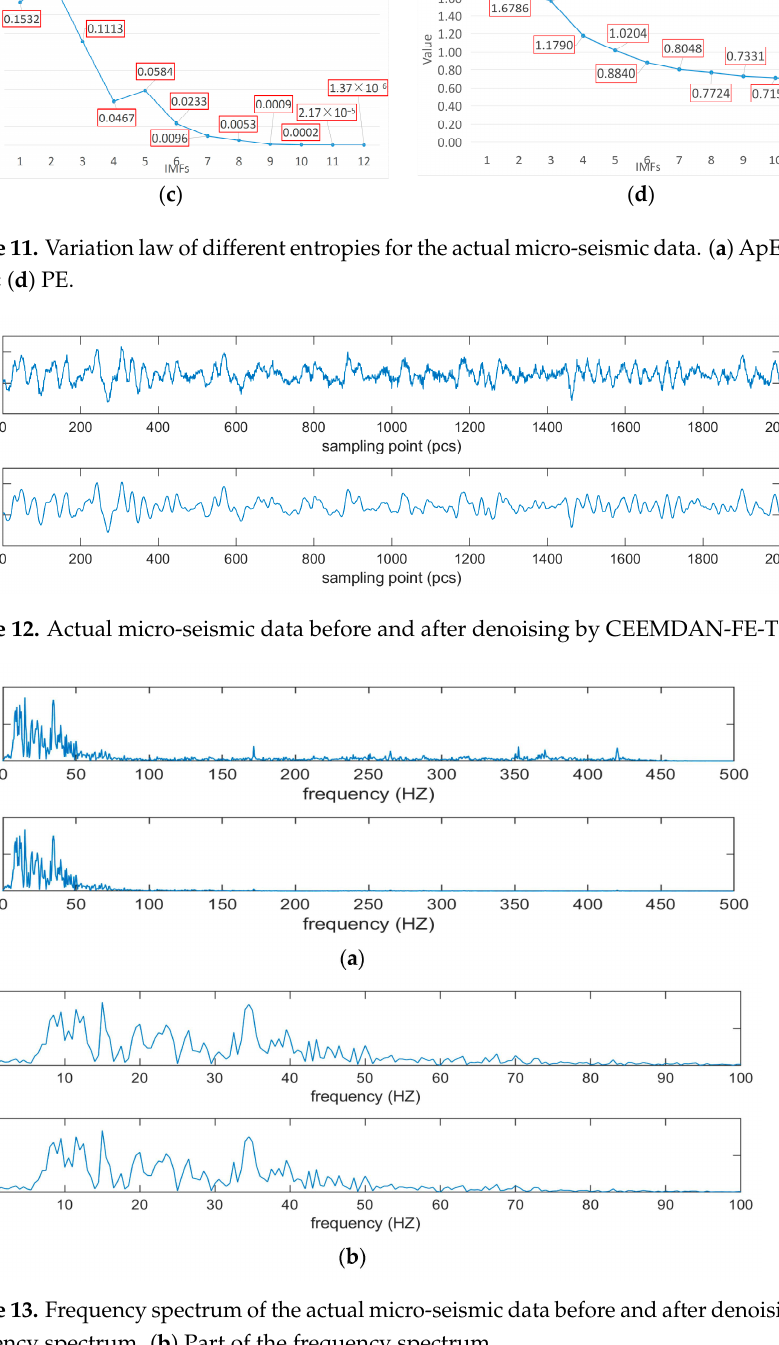
Figure 13. Frequency spectrum of the actual micro-seismic data before and after denoising. ( a ) Overall frequency spectrum. ( b ) Part of the frequency